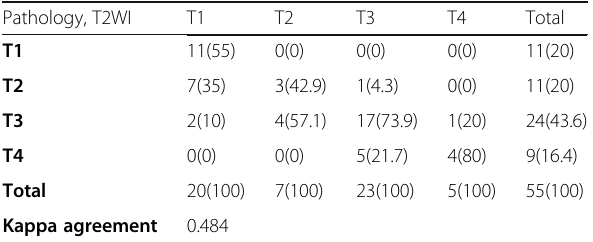
Table 6 Agreement between T2WI and histopathological Table 7 Agreement between DWI and